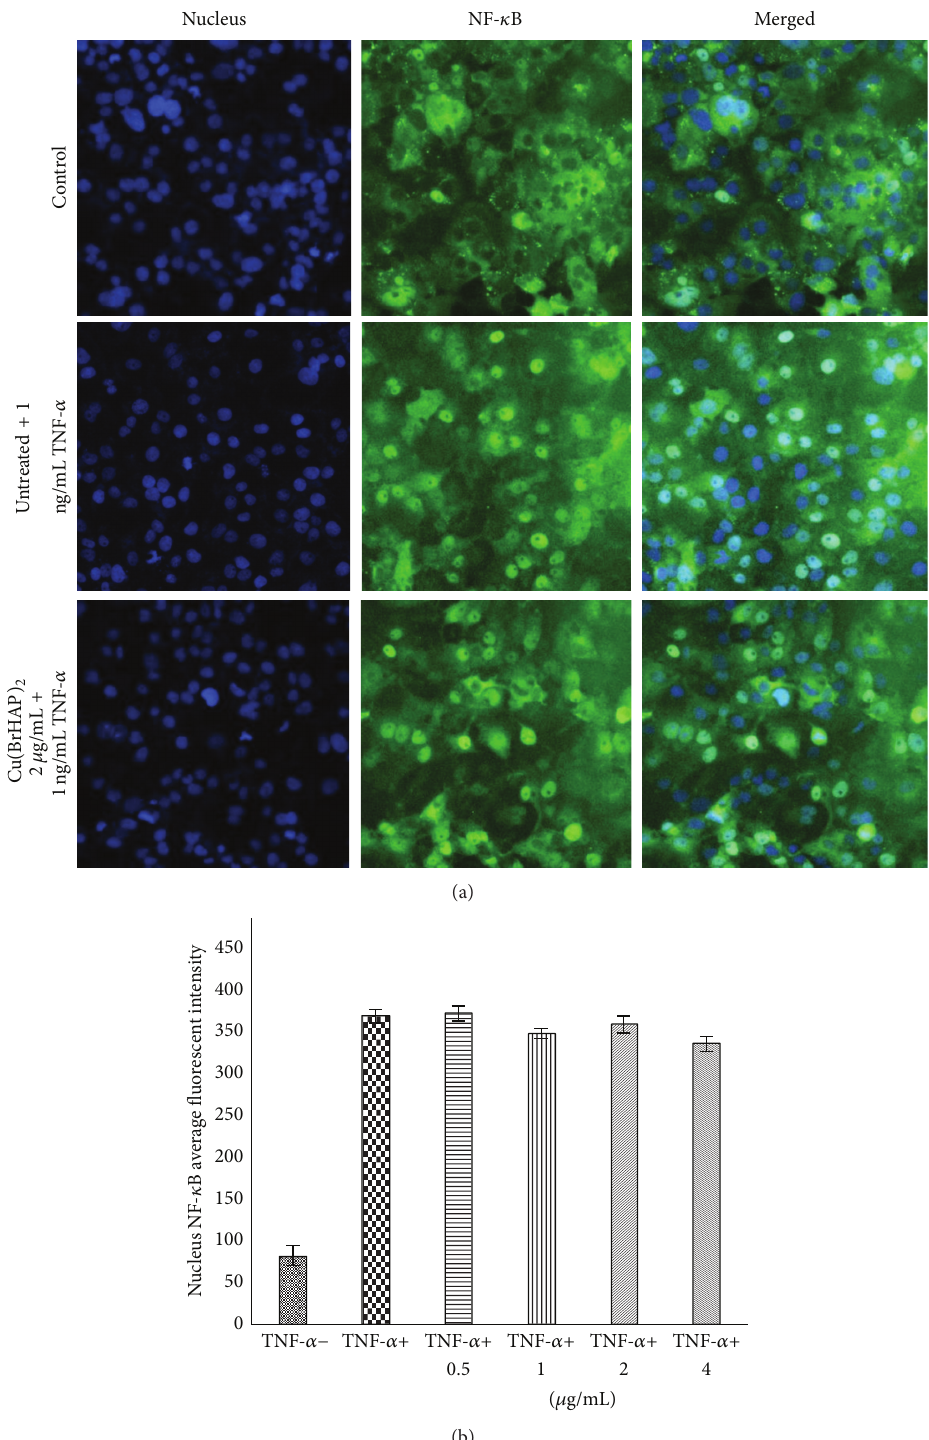
Figure 9: (a) Photographs of the intracellular targets of stained HT-29 cells that were treated with Cu(BrHAP) 2 (2 𝜇 g/mL) for 3 h and then stimulated for 30 min with 1ng/mL TNF- 𝛼 (NF- 𝜅 B activation). (b) Representative bar chart indicating that Cu(BrHAP) 2 treatment caused no changes in TNF- 𝛼 -induced NF- 𝜅 B nuclear translocation in HT-29